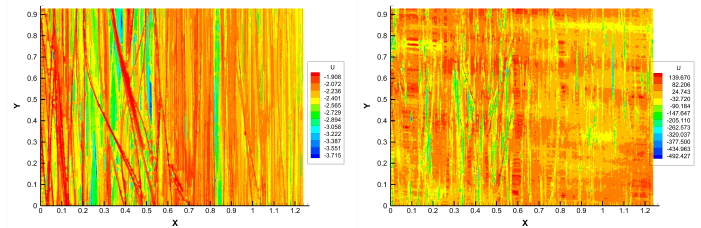
Figure 8. Surface topography before ( left ) and after ( right )